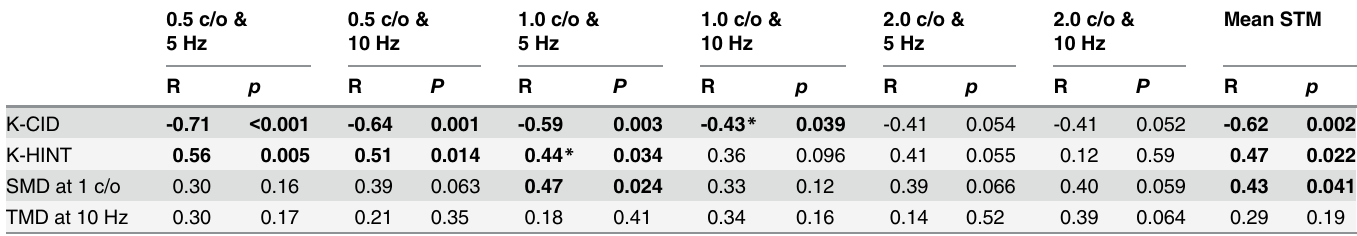
Table 4. Correlations of STM detection test measures with sentence recognition in quiet (K-CID) and in noise (K-HINT), spectral modulation detec- tion (SMD) and temporal modulation detection (TMD) tests in CI subjects. R is the Pearson correlation coefficient, and p is the significance. Bold values indicate significant correlations at the level of 0.05. The asterisks indicate the conditions where the correlations became no longer significant after factoring out the effects of subjects ’